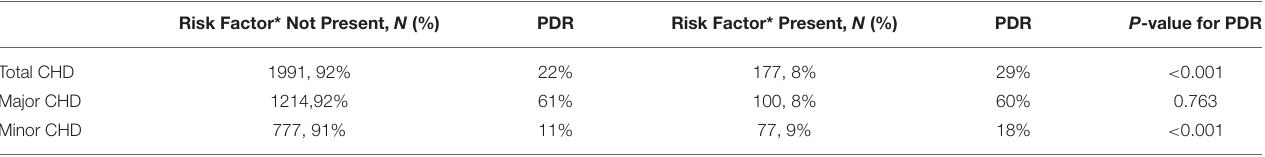
TABLE 3 | Prenatal CHD diagnosis rates by presence of additional CHD risk factors.